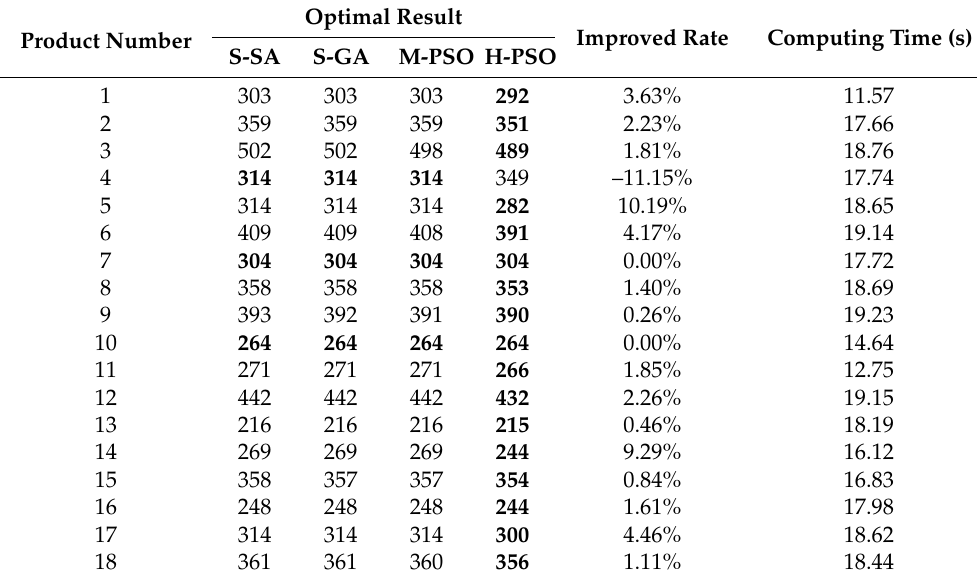
Table 6. The optimal result comparison of di ff erent algorithms in case